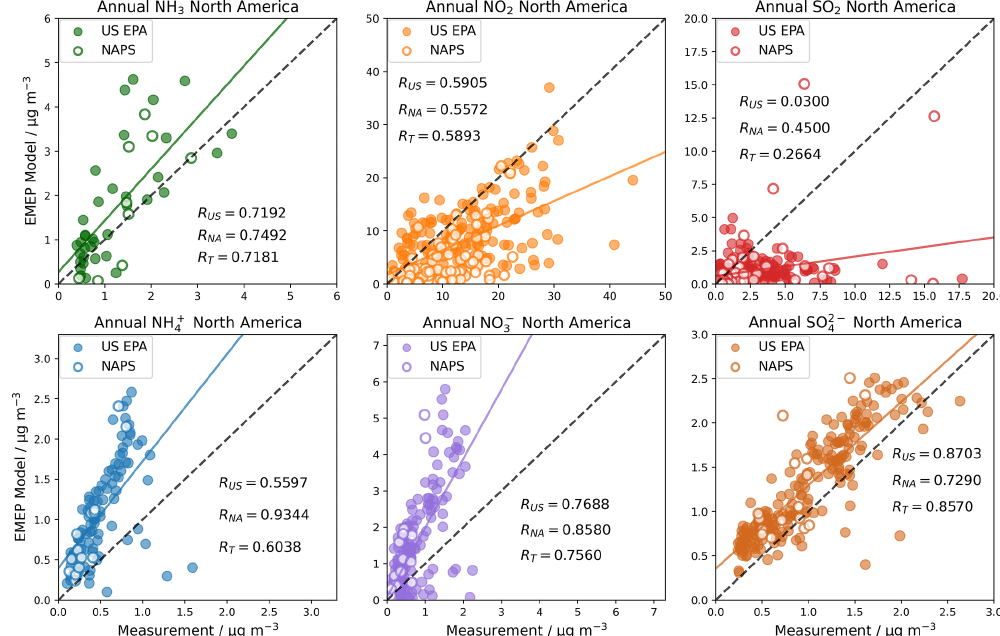
Figure 10. Scatter plots of 2015 annual mean modelled and measured NH 3 , NO 2 , HNO 3 , SO 2 , NH 4 + , NO 3 − , and SO 42 − concentrations at North American monitoring network locations. In each plot, the solid line is the least-squares regression line and the dashed black line is the 1 : 1 line. R US is for U.S. EPA network. R NA is for NAPS network. R T is the overall correlation coefficient between model and all measurements shown. Table 4. Summary statistics of model comparison with measurements for 2015 in North America (U.S. EPA and NAPS networks). N is the number of paired data of model and observation. R T is Pearson’s coefficient for total measurements in U.S. EPA and NAPS networks. Fac2 is the fraction of data points within a factor of 2. Mean_O and Mean_M are annual average concentrations (µgm − 3 ) of observation and model, respectively. NMB is normalized mean bias, NME is normalized mean